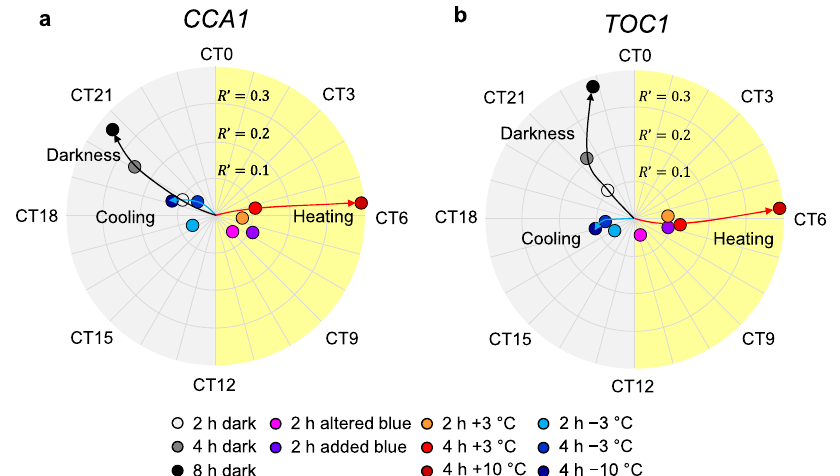
Fig. 3 Mapping and comprehensive comparison of SRs for various stimuli. a , b Circadian time (CT) of Θ ′ and R ′ in CCA1 :: LUC ( a ) and TOC1 :: LUC ( b ). R ′ is the distance from the center point. The graphs represent the results as means ( n = 17 – 72).